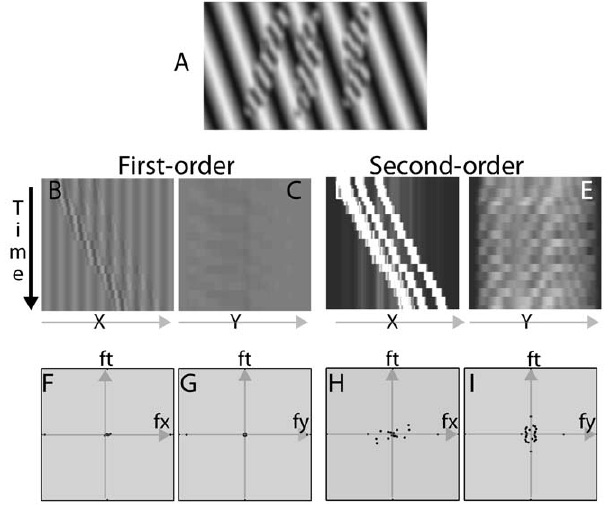
Figure 2. Motion energy analysis for the peripheral escalator illusion (See Movie S1). A) A single frame of the peripheral escalator illusion. The background is a stationary gradient. The three blurred columns shift horizontally back and forth. The columns are perceived as drifting horizontally when viewed in the fovea, but obliquely when viewed in the periphery. B&C) First-order motion plots in the x-t and y-t planes. D&E) Projections of DC-removed and rectified second-order peripheral escalator movie in the x-t and y-t planes. F–I) Fourier analysis of the first-order and second-order motion energy of the peripheral escalator movie in the fx-ft and fy-ft